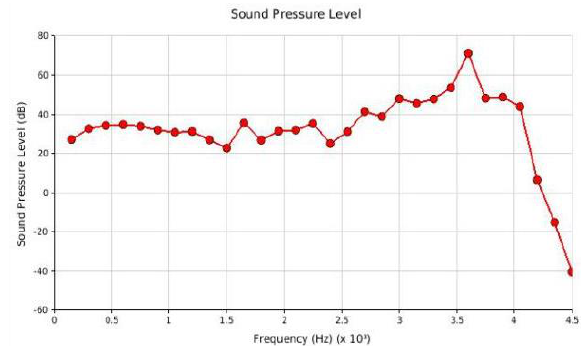
Figure 24. Value-loaded electromagnetic noise at a speed of 3000 rpm.